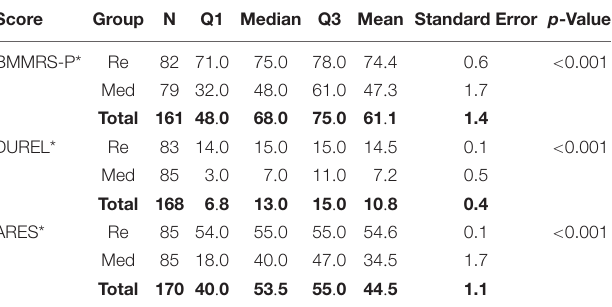
TABLE 4 | Summary measures for scale scores brief multidimensional measure of religiousness/spirituality, duke religion index and attitudes related to spirituality scale.